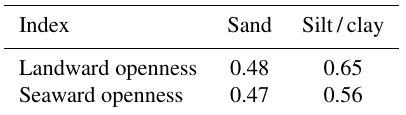
Table 1. Correlation ( r 2 , p < 0 . 01) matrix for the grain-size data and the calculated openness